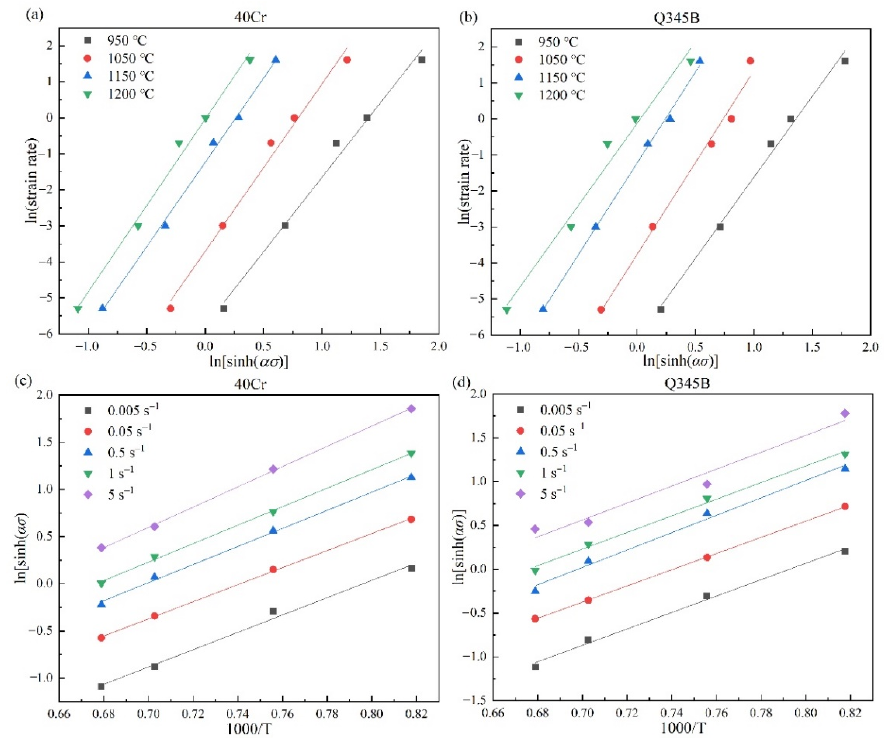
Figure 10. Relationships between ln 𝜀(cid:4662) − σ ( a , b ) and ln 𝜀(cid:4662) − ln σ ( c , d ) for 40Cr and Q345B, respectively.